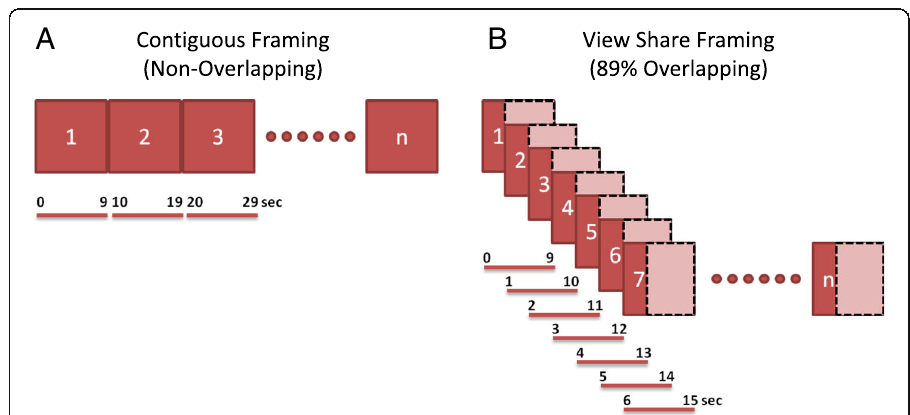
Fig. 1 Visual representations of ultra-short contiguous (non-overlapping) frame reconstruction [11] ( a ) and view-sharing (89 % overlapping) frame reconstruction ( b ) used with stationary and rotating gantry PET systems,